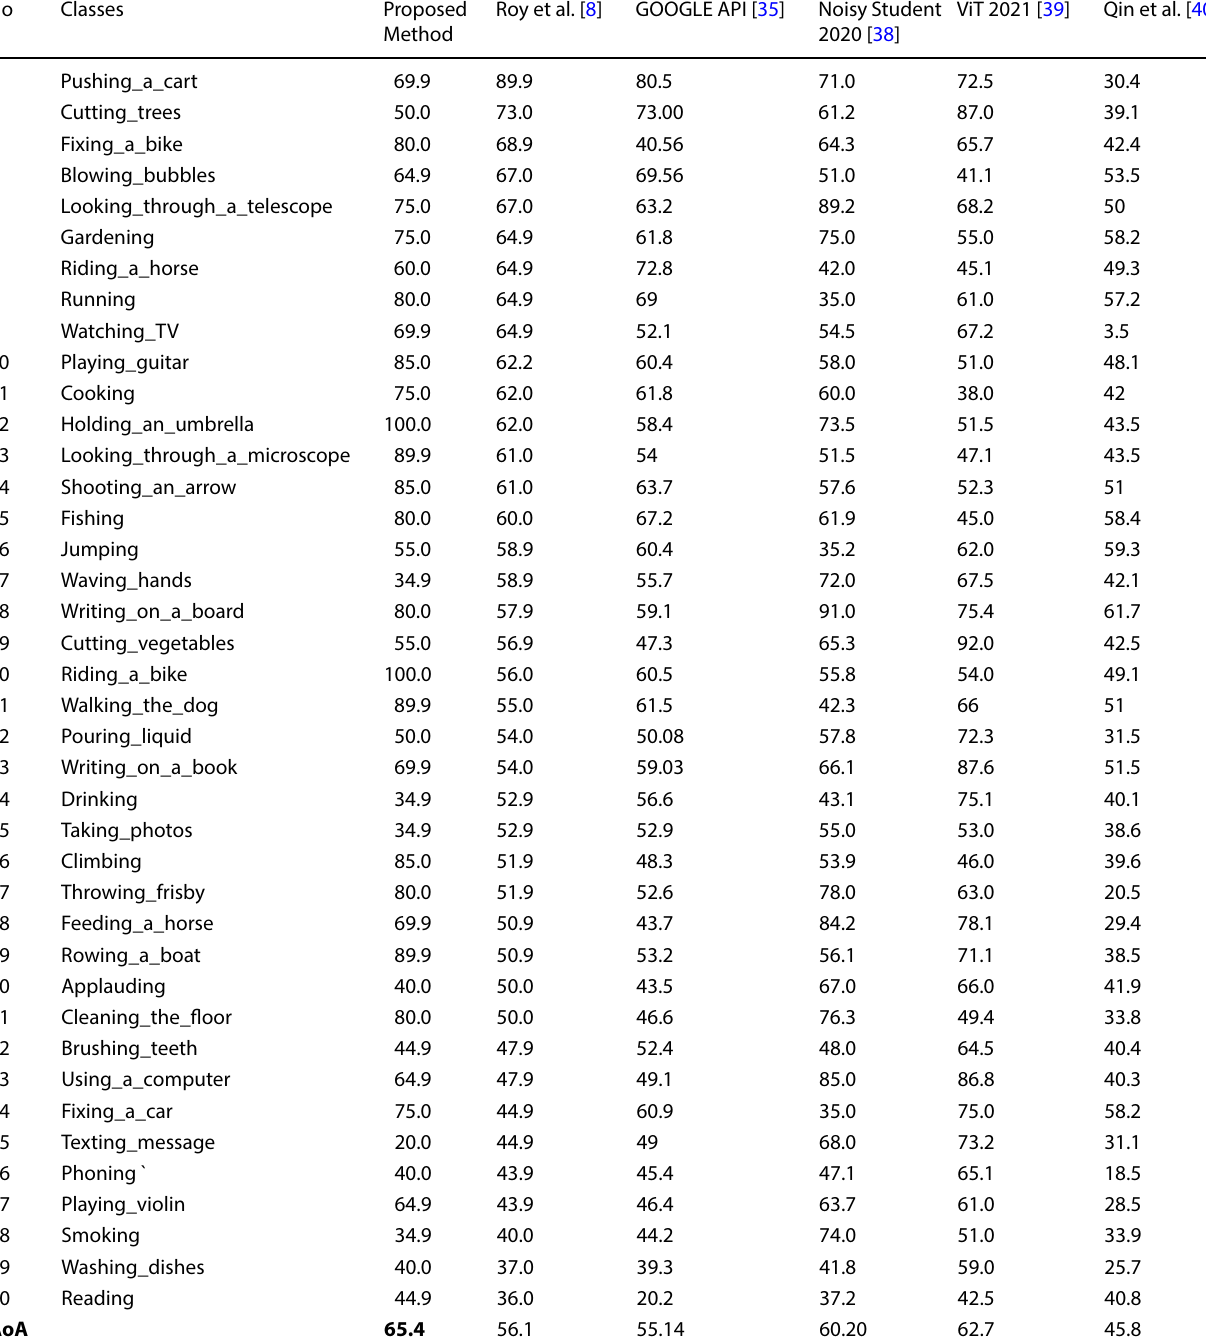
Table 9 Average Classification Rate of the Proposed and Existing Approach on Stanford 40 Actions